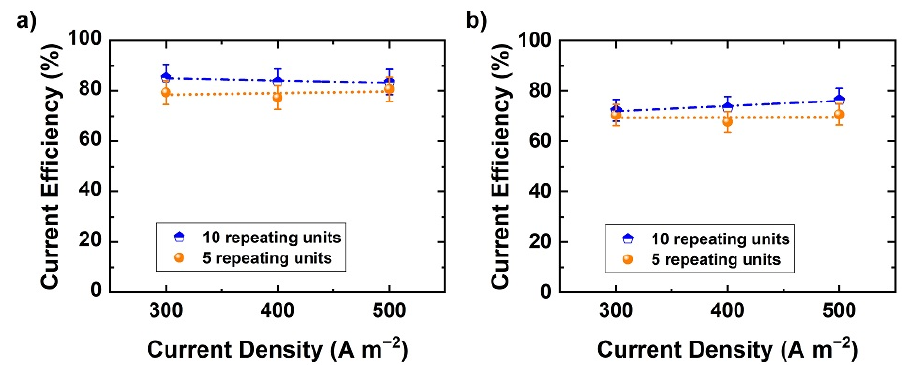
Figure 8. Current efficiency variation as a function of number of RUs at different current densities: ( a ) NaOH and ( b ) H 2 SO 4 .